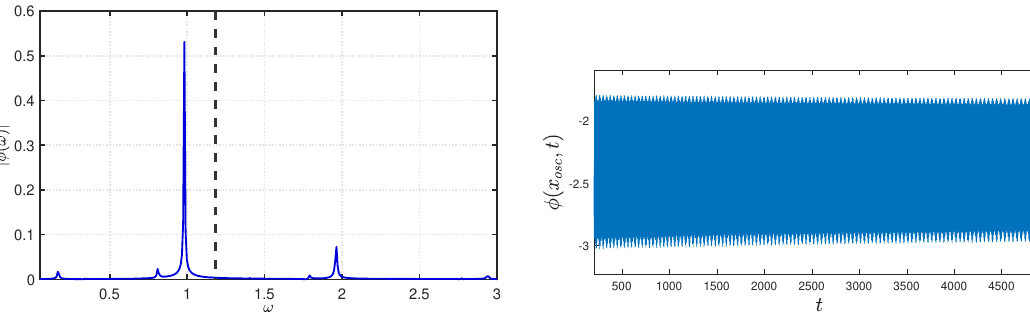
Figure 14 . Large kink-antikink collision: a) Fourier transform of one propagating oscillation for 100 < t < 800 shown in the figure 7. The dashed line corresponds to the threshold of the continuum modes. b) Oscillations of the figure 7 up to t =